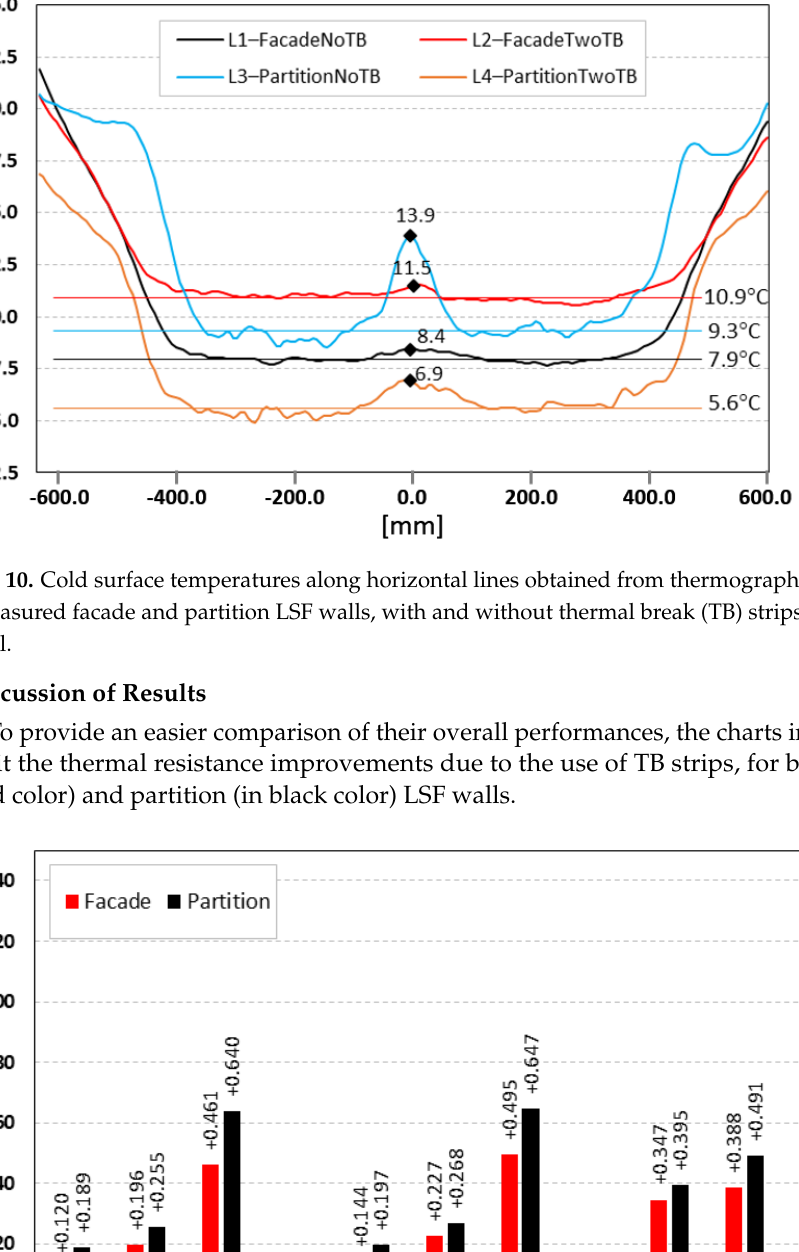
Figure 11. The increase in thermal resistances due to thermal break (TB) strips ’ use in load-bearing LSF walls: facade vs partition [30].